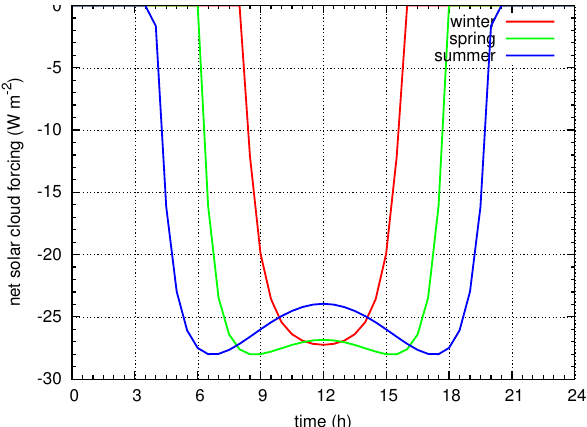
Figure 10. Diurnal cycle of SCF for zenith angles calculated for 21 March (spring, green), 21 June (summer, blue) and 21 December (winter, red) for 50 ◦